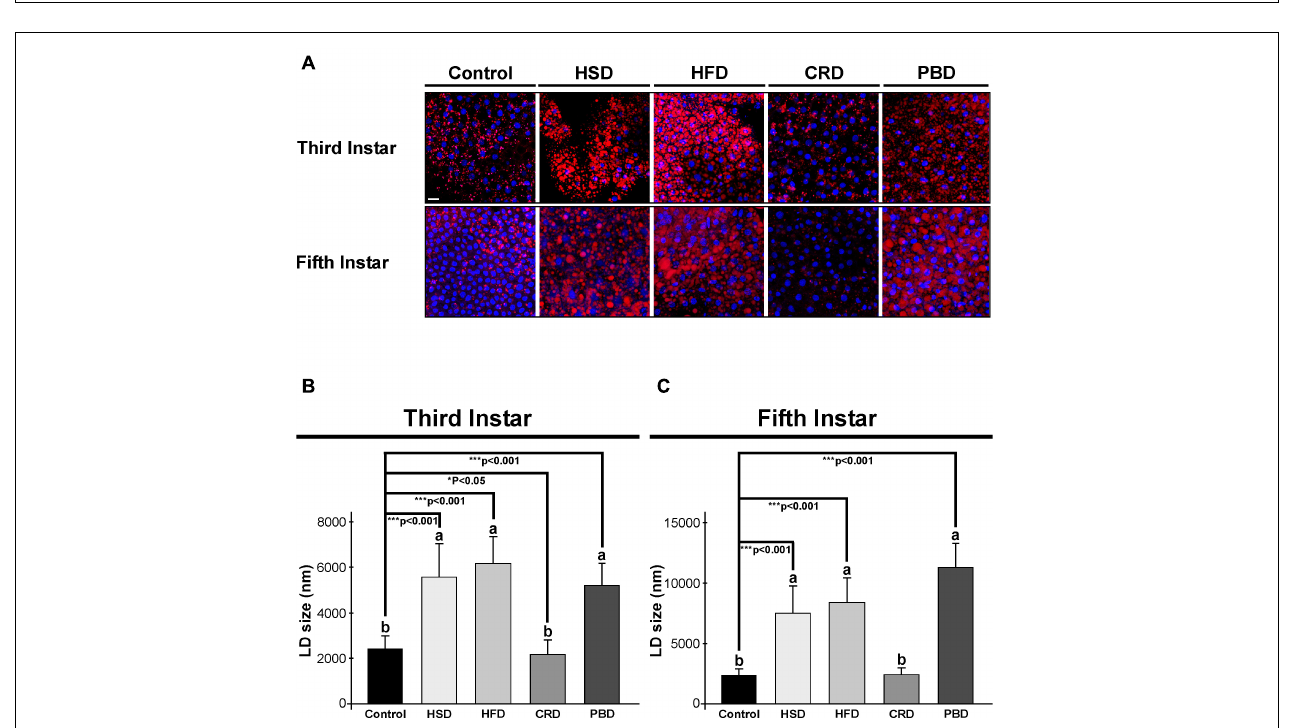
FIGURE 4 | Effects of different diet treatments on the fat body lipid droplets of Spodoptera littoralis . The depict lipid droplets using confocal microscopy in fat body tissue from third or fifth instar larvae (A) , and lipid droplet sizes at third (B) and fifth instar larvae (C) are shown. Lipid droplets stained with Nile red dye in red, nuclei stained with Hoechst in blue. Statistical significances in the entire sample set were determined by using one-way ANOVA, followed by a Tukey HSD test (groups associated with different letters are significantly different among each other, p < 0.05). A t -test was used for binomial comparisons (diet treatment vs control) (* p < 0.05, *** p < 0.001 indicate the statistical differences between the particular diet and the control). Values are expressed as means ± standard error. Control, Regular artificial bean diet; HSD, High sugar diet; HFD, High fat diet; CRD, Calcium-rich diet; PBD, Plant-based diet. Scale bar, 20 µ m in panel (A)